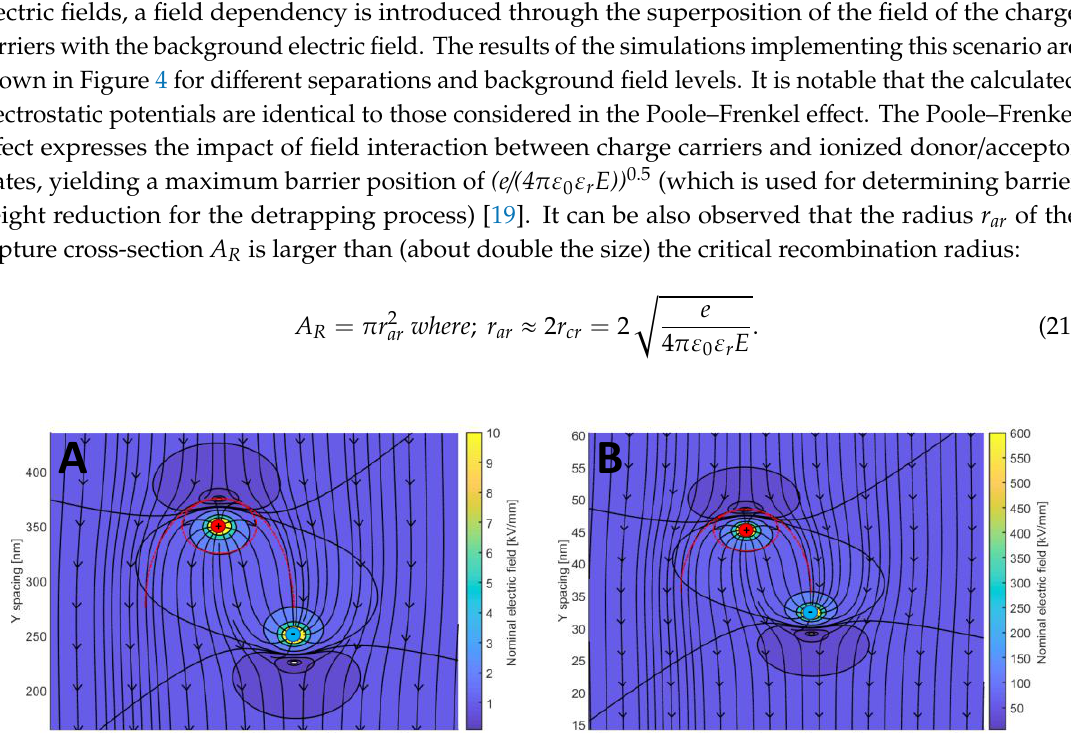
Figure 5. Charge recombination scheme (mobile electron–trapped hole) assuming similar charge movement patterns to the trapping process (Figure 3), but with the added effect of local coulombic interaction between the participating charge carriers. Shallow traps are assumed to be uniformly spread with a cubic lattice.